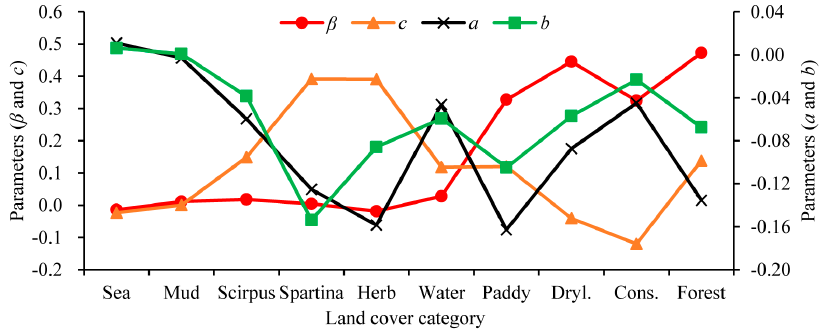
Figure 4. The values of the four parameters ( β intercept, c trend, a harmonic cos, b harmonic sin) in the time-series model for different land cover classes based on the reference samples for each land cover category (note: the trend value c was enlarged by 10 4 ; Dryl., dryland; Cons., construction land).